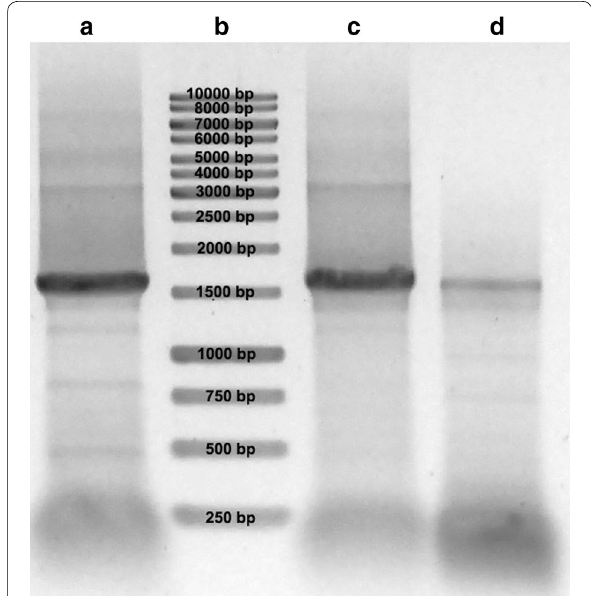
Fig. 3 PCR of comp15071_c0_seq5 (Lcc5B) with three different polymerases. Bands with the length of approximately 1.500 bp cor- respond to the predicted size of the sequence. a amplification with Pfu platinum DNA polymerase (Thermo Scientific), b 1-kb